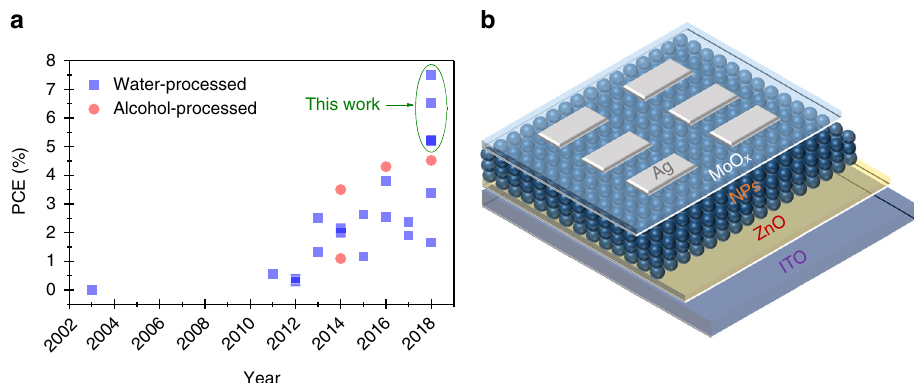
Fig. 1 Water/alcohol-processed NP solar cells. a Ef fi ciency evolution of NP-based organic solar cells processed by water/alcohol. b Device architecture of NP-based organic solar cells in